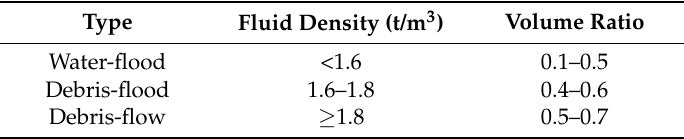
Table 1. Classification criteria for the three types of debris flow events.